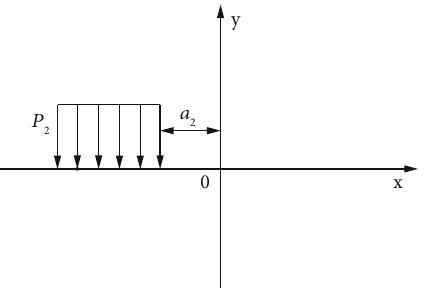
Figure 7: Basic mechanical constitutive model of coal wall